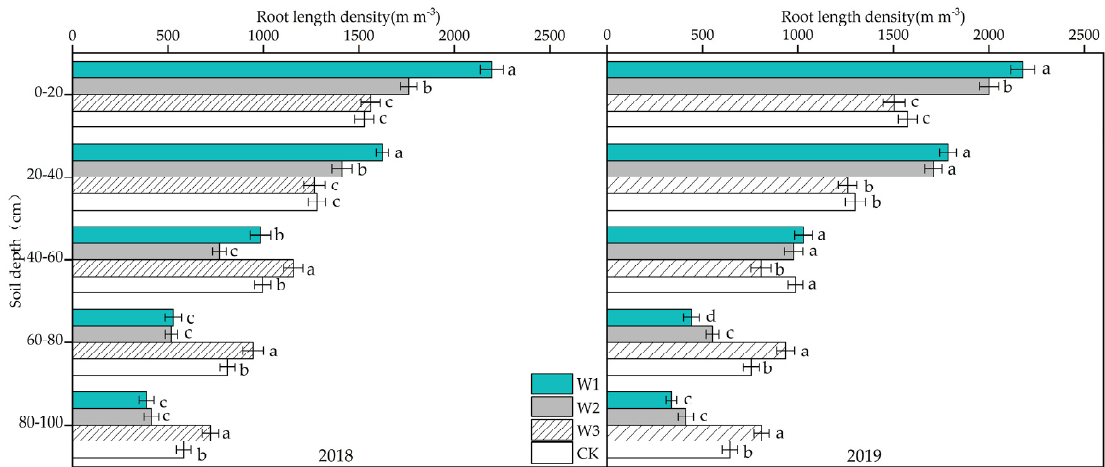
Figure 6. Vertical distribution of jujube RLD in 2018 and 2019. W1, W2, and W3 indicate irrigation amounts of 880, 660, and 440 mm under drip irrigation, CK indicates irrigation amount of 1100 mm under flood irrigation. Horizontal bar represents standard error. Different lower-case letters indicate significant differences at 0.05 level among various groups.